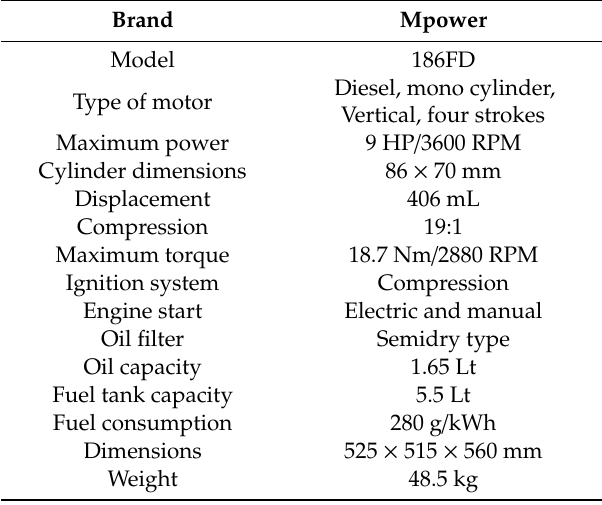
Table 1. Technical characteristics of the